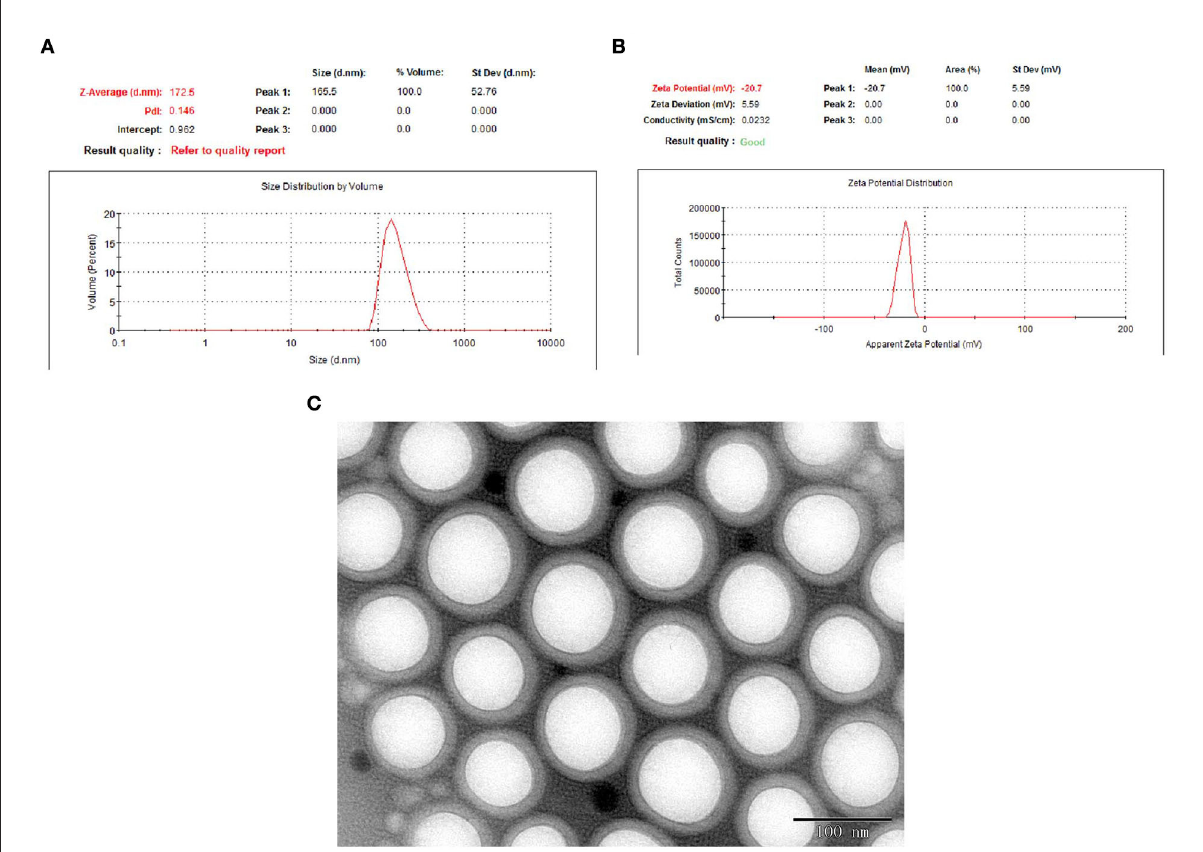
FIGURE2 Optimization of EGCG-NPs. Particle size distribution of EGCG-NPs measured with electrophoretic light-scattering (ELS) analyzer (A) . Zeta potential measurement of EGCG-NPs (B) . TEM image of EGCG-NPs (C) . Scale bar =